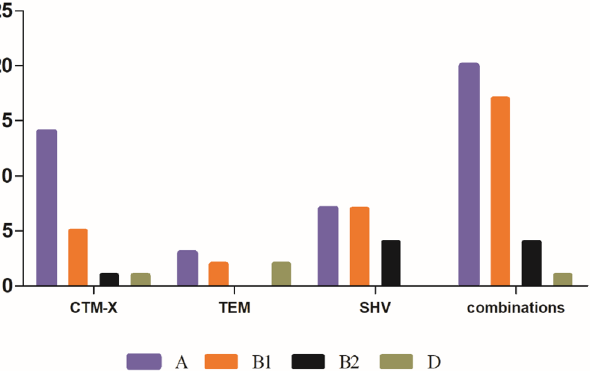
Figure 4. Distribution of beta lactam genes ( bla CTX-M , bla TEM , bla SHV ) and their combinations into various phylogroups (n =